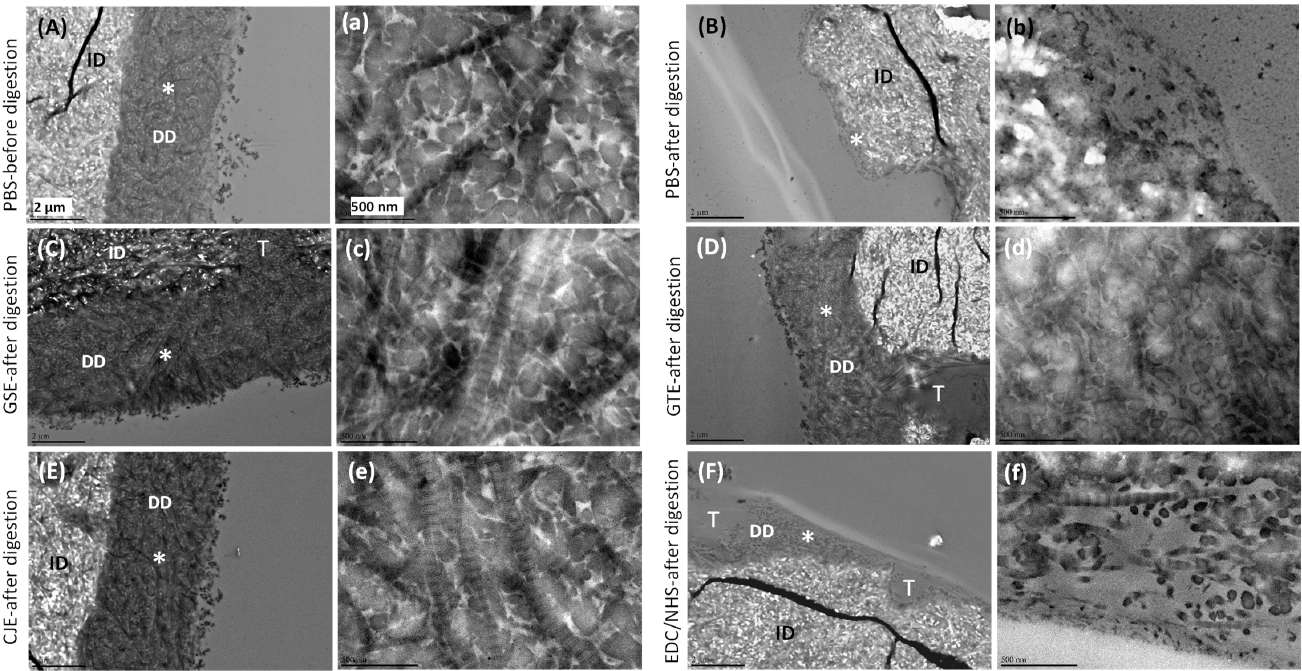
Figure 4. ( A – F ) Representative TEM images of the untreated PBS control and cross-linker-treated demineralized dentin layers before and after 1 h of digestion in 0.1% collagenase. ( a – f ) Representative high-magnification view of the top demineralized dentin layer from the same upper-case-letter figure in the area labeled as *. ( A , a ) PBS control before digestion. ( B , b ) PBS control after digestion. ( C , c ) GSE-treated group after digestion. ( D , d ) GTE-treated group after digestion. ( E , e )